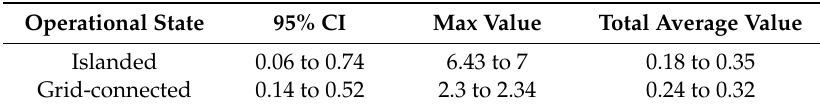
Table 5 . 95% confidence interval, the maximum 10 min value and total average value for all three phases in islanded and grid-connected operation.